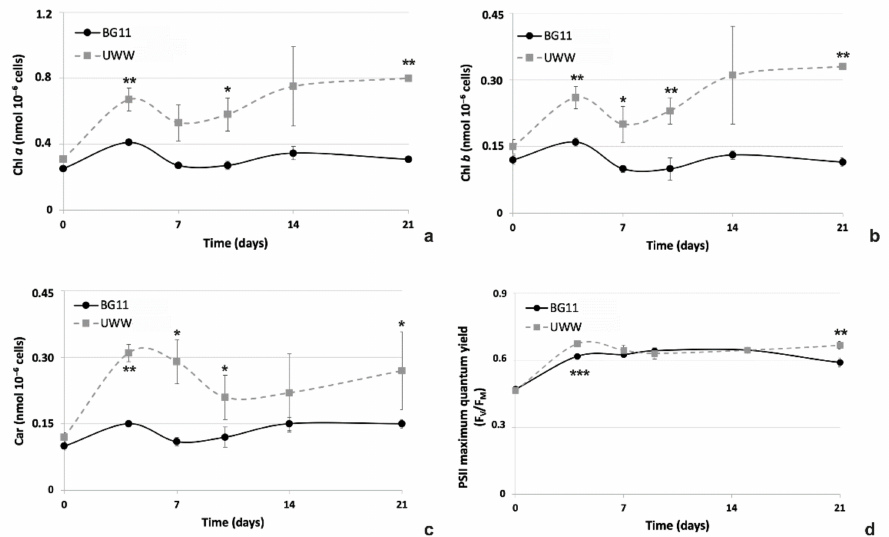
Figure 7. Photosynthetic pigment content (nmol pigment 10 − 6 cells) and PSII maximum quantum yield (F V / F M ratio) of microalgae cultivated in UWW and modified BG11 for 21 days. ( a ) Chlorophyll a , ( b ) Chlorophyll b , ( c ) Carotenoids and ( d ) PSII maximum quantum yield. UWW, grey dash line; BG11, black line. Data refer to means ± standard deviations (n = 3). Asterisks identify significant di ff erences between samples: *, p ≤ 0.05; **, p < 0.01; ***, p <